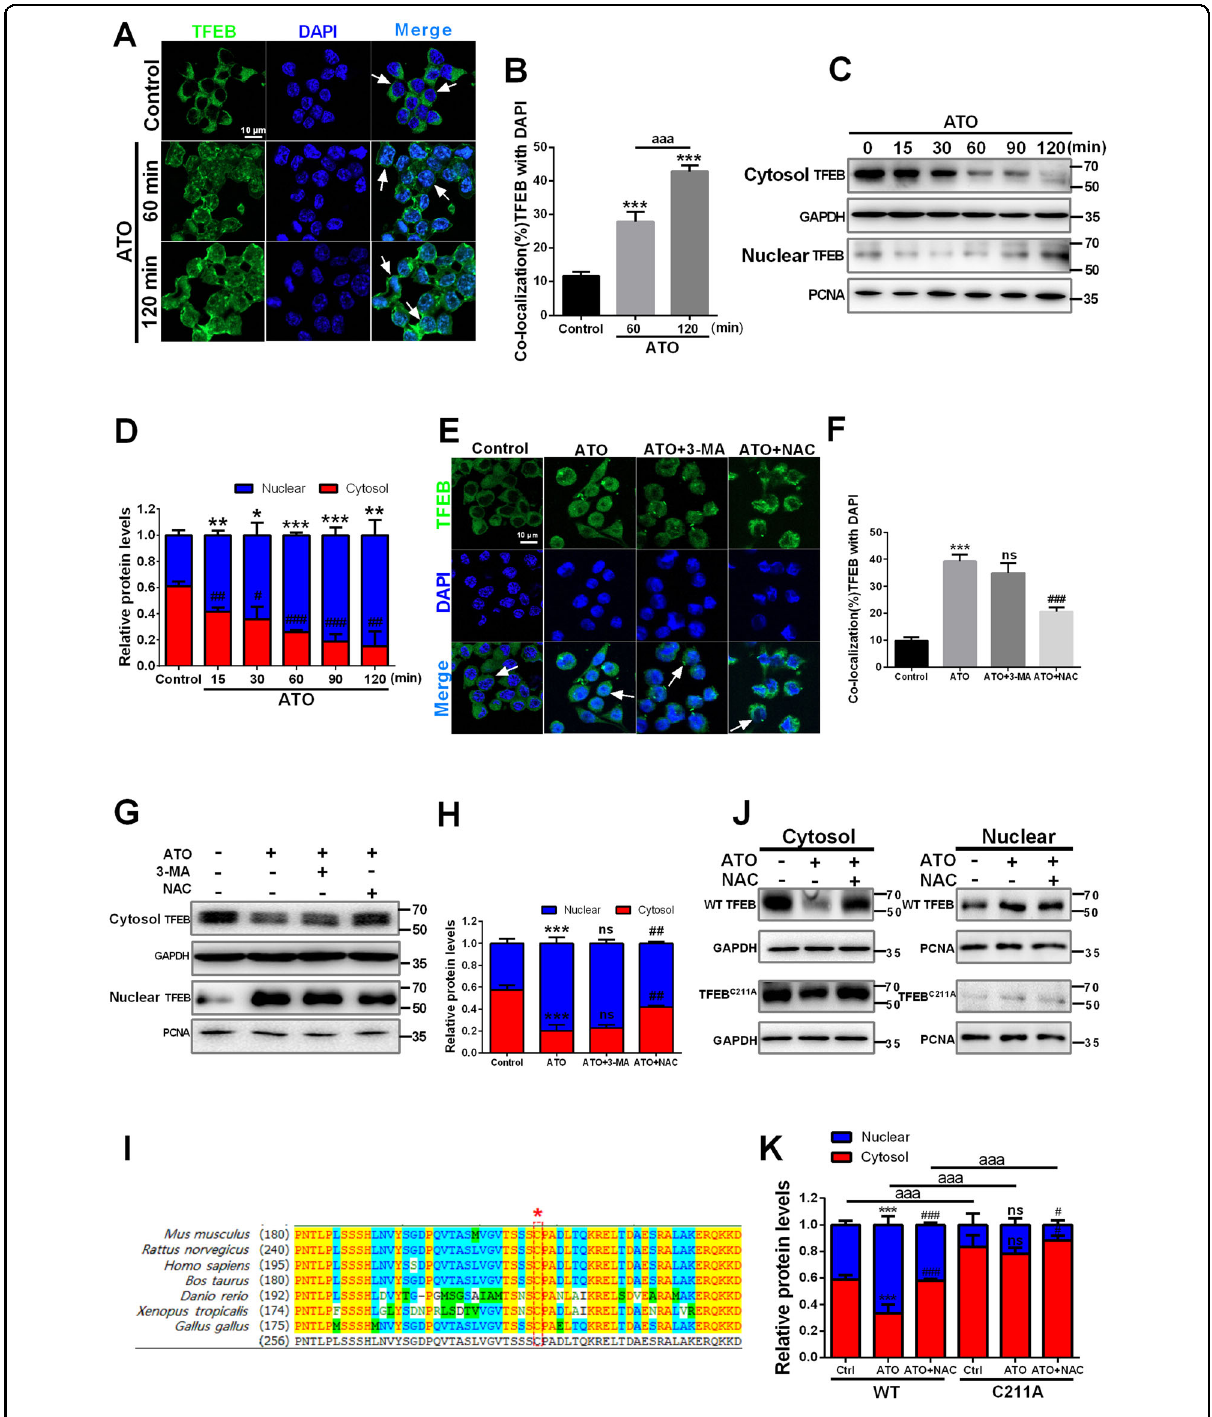
Fig. 4 (See legend on next